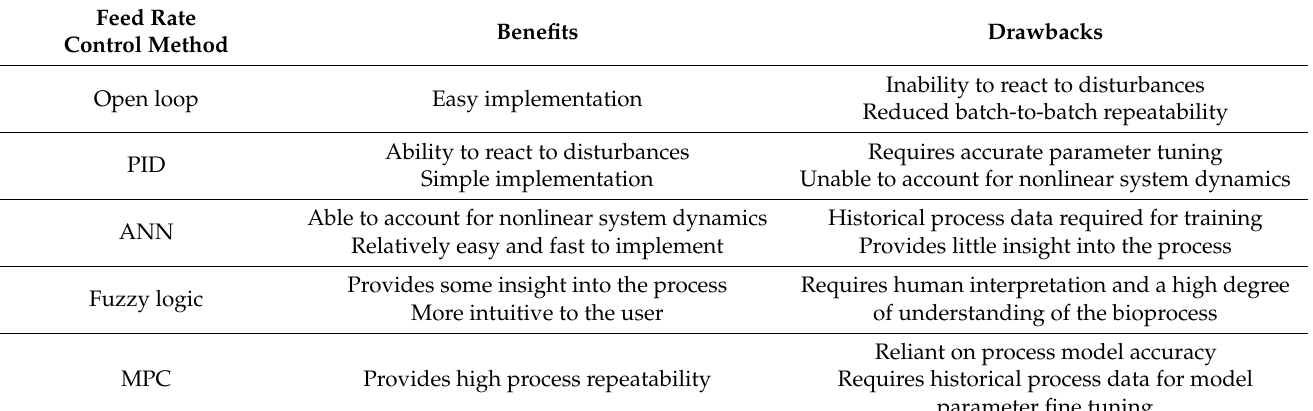
Table 1. A comparison of substrate feed rate control methods in fed-batch